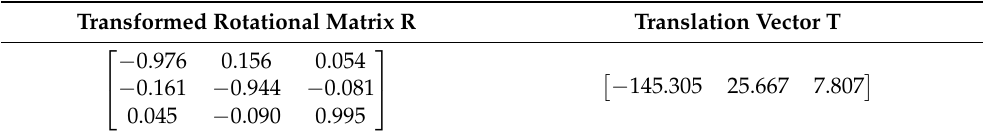
Table 5. Camera-to-scanning galvanometer